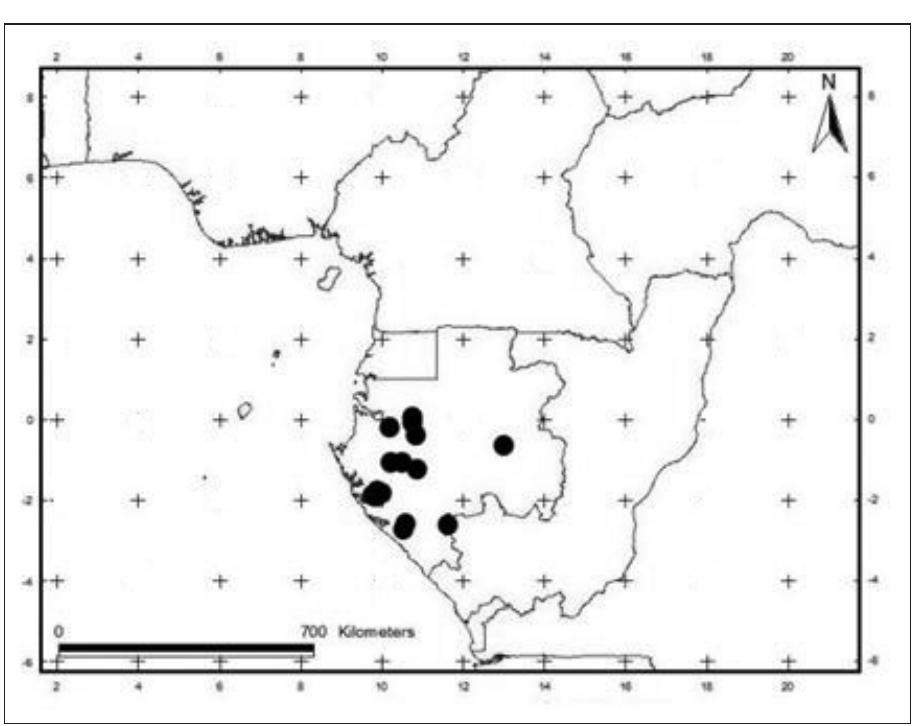
Figure 4. Distribution map of Craterispermum